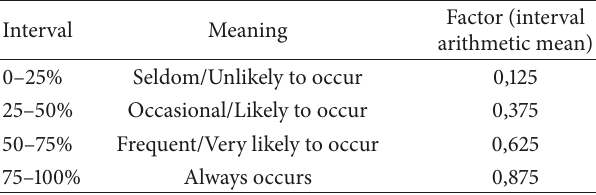
Table 6: Intervals and their interval